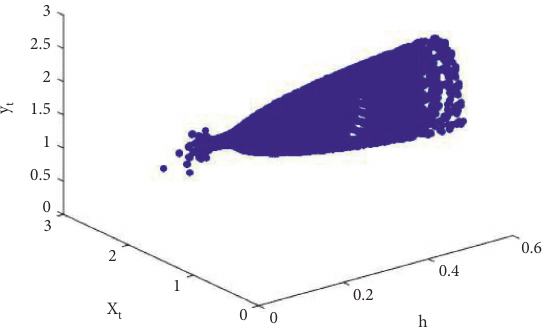
Figure 5: The 3D bifurcation diagram of the Brusselator system